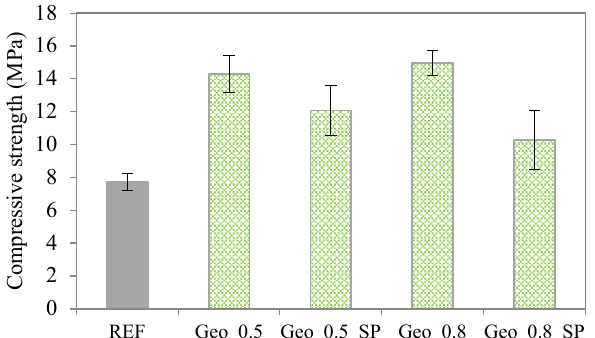
Figure 5. Open porosity of grouts studied.